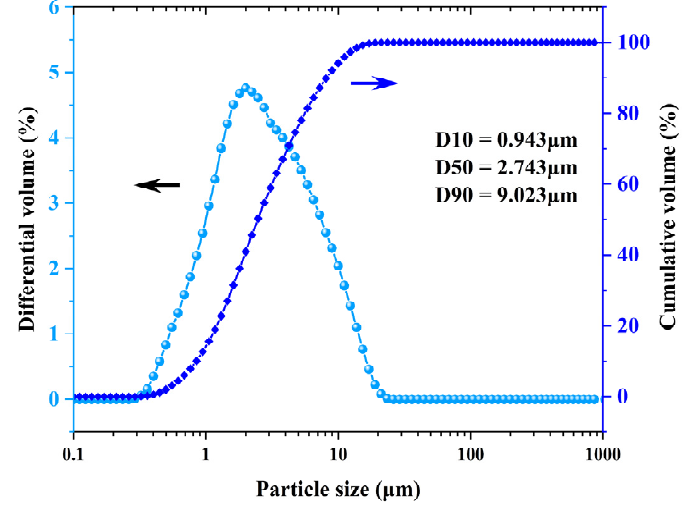
Figure 2. Particle size distribution of metakaolin.